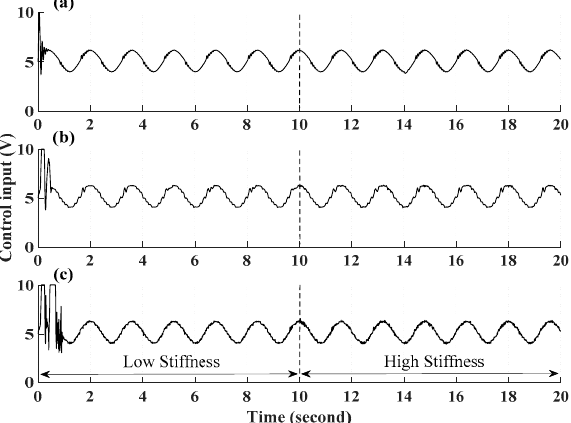
Figure 10. The control signal of ( a ) the PID control, ( b ) CBSMC, and ( c ) the proposed ABSMC. The error responses of PID, CBSMC, and ABSMC are plotted in Figure 8 with the blue dash line, the black dashed dot line, and the red line, respectively. The results exhibited that the ABSMC with approximators improved the precision of the system more effectively than the PID and CBSMC.